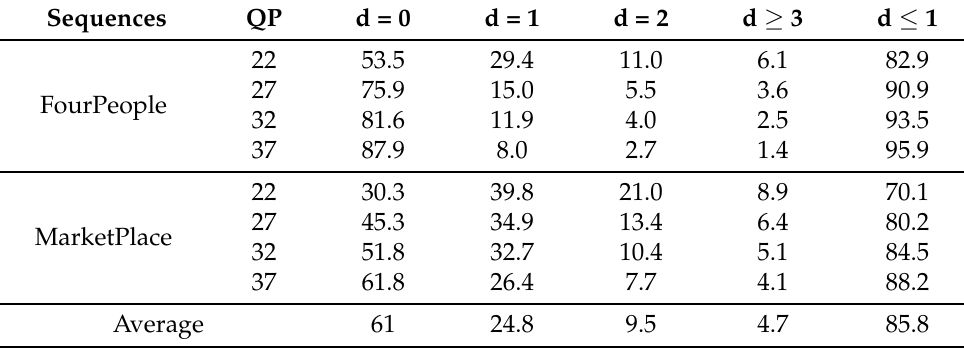
Table 5. The distribution of the MT depth difference between adjacent frames (unit: